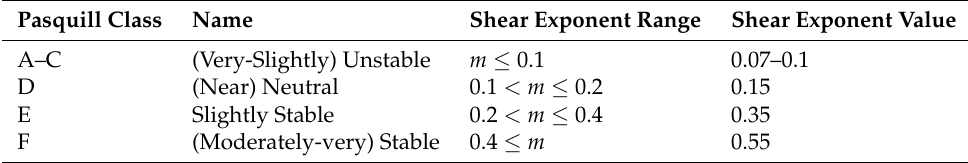
Table 2. Stability classification with wind shear exponent